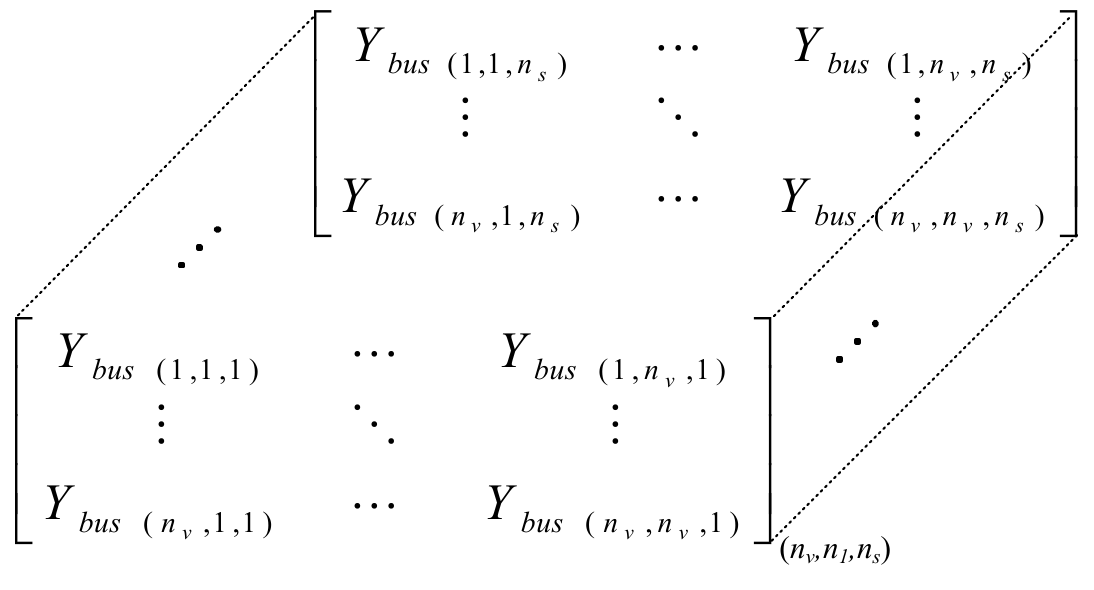
Figure 7. Three-dimensional admittance matrix.